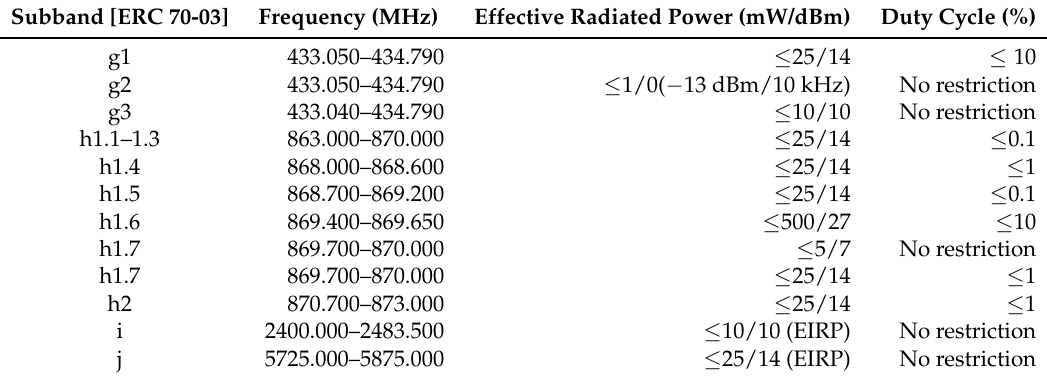
Table 3. Sub-bands for non-specific short range devices (based on Refs.